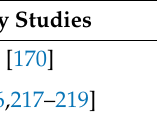
Intensified SN functional connectivity was observed in AD